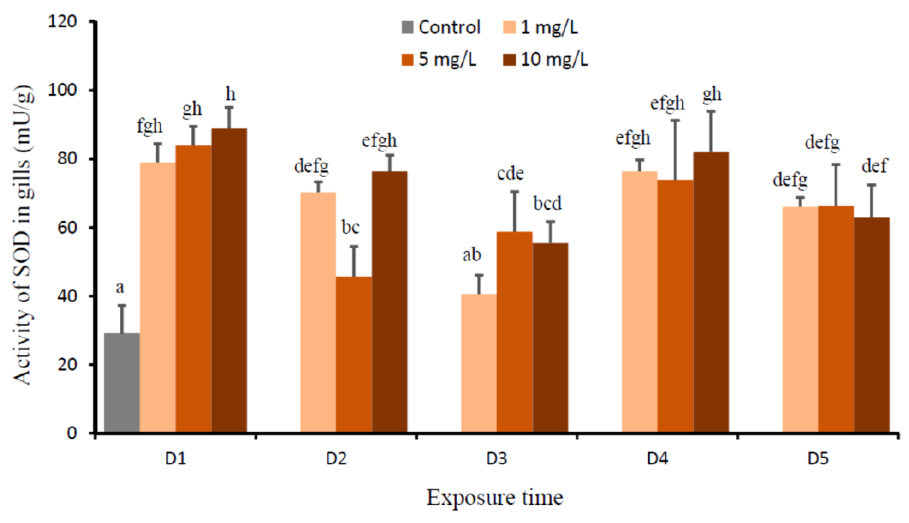
Figure 3. Activity of superoxide dismutase (SOD) (mU/g) in gills of O. niloticus of the control group and after exposed to 1, 5, and 10 mg Cu/L. Different lowercase letter indicates significance difference < 0.05). according to Tukey multiple comparison test ( P < 0.05). according to Tukey multiple comparison test ( P